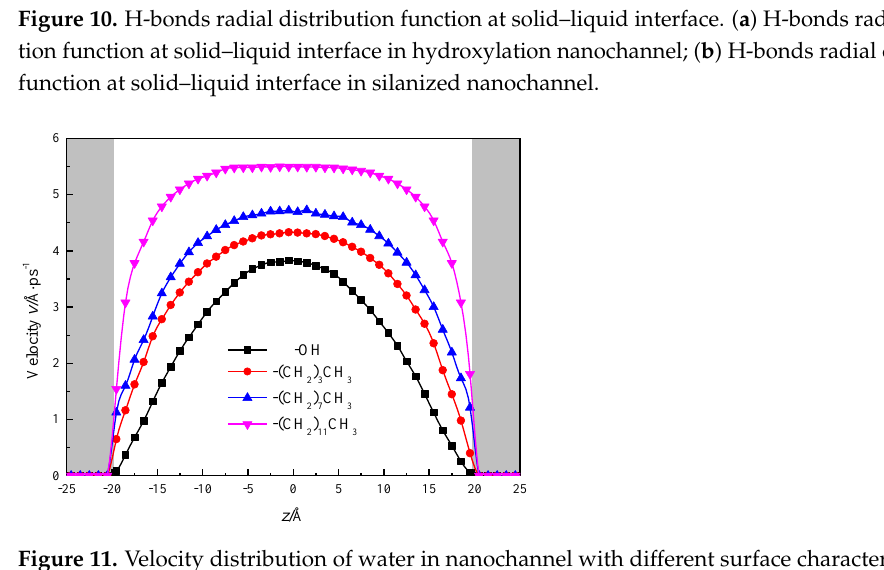
Figure 11. Velocity distribution of water in nanochannel with different surface characteristics.